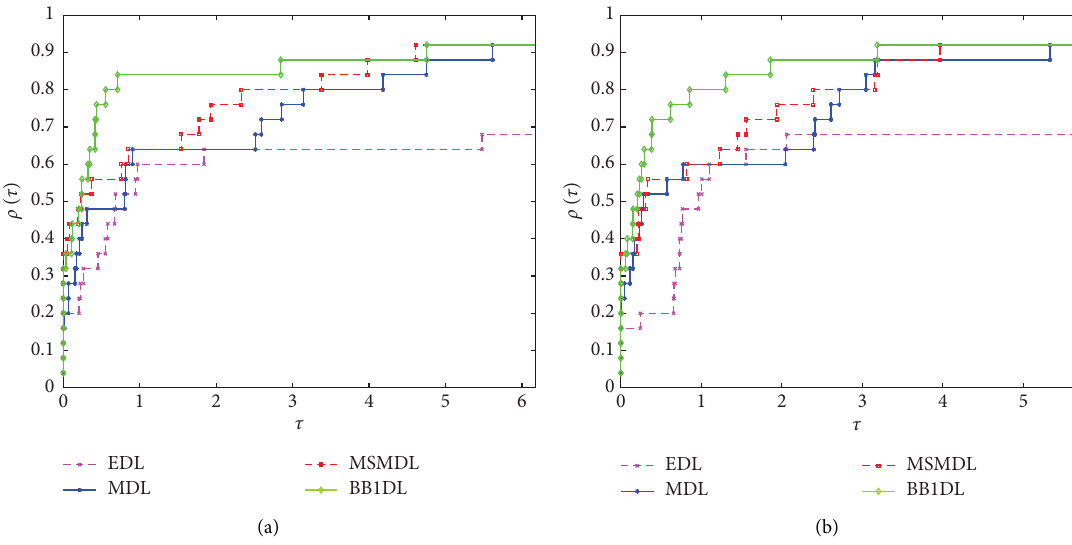
Figure 4: (a) NI and (b) NFE performance profles for EDL, MDL, MSMDL, and BB1DL.